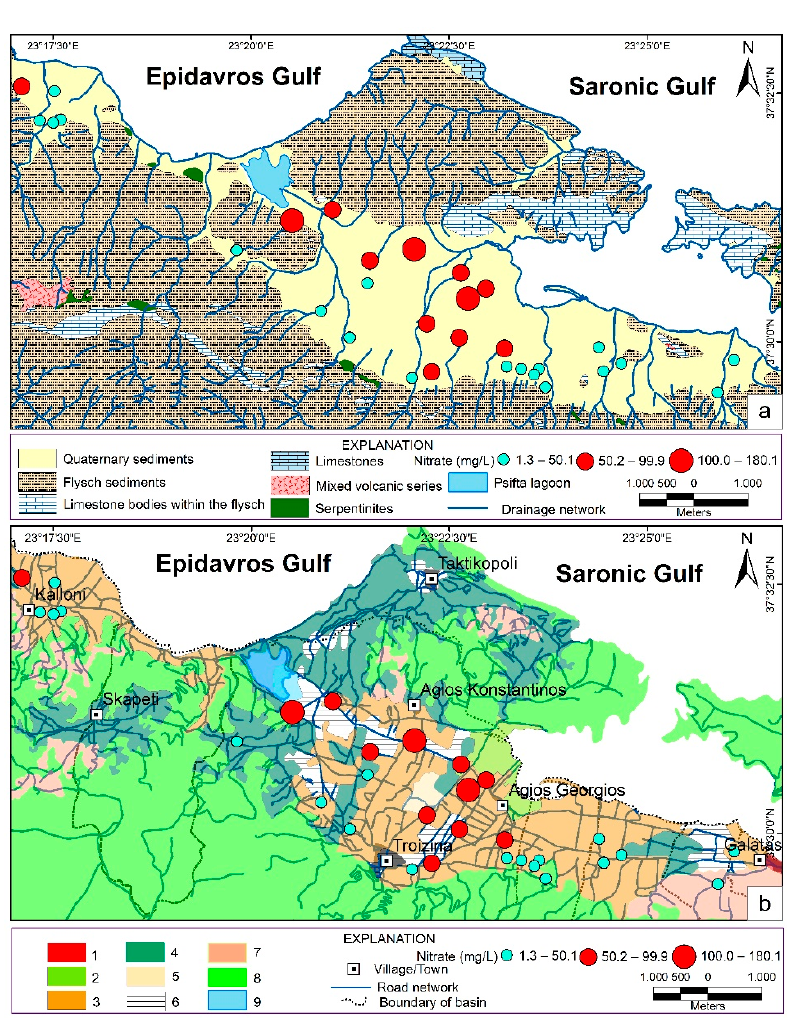
Figure 5. Graduated symbol plots of nitrate concentration in groundwater of the study area compared with ( a ) geology and ( b ) land uses (the explanation of land uses is shown in the caption of Figure 2).